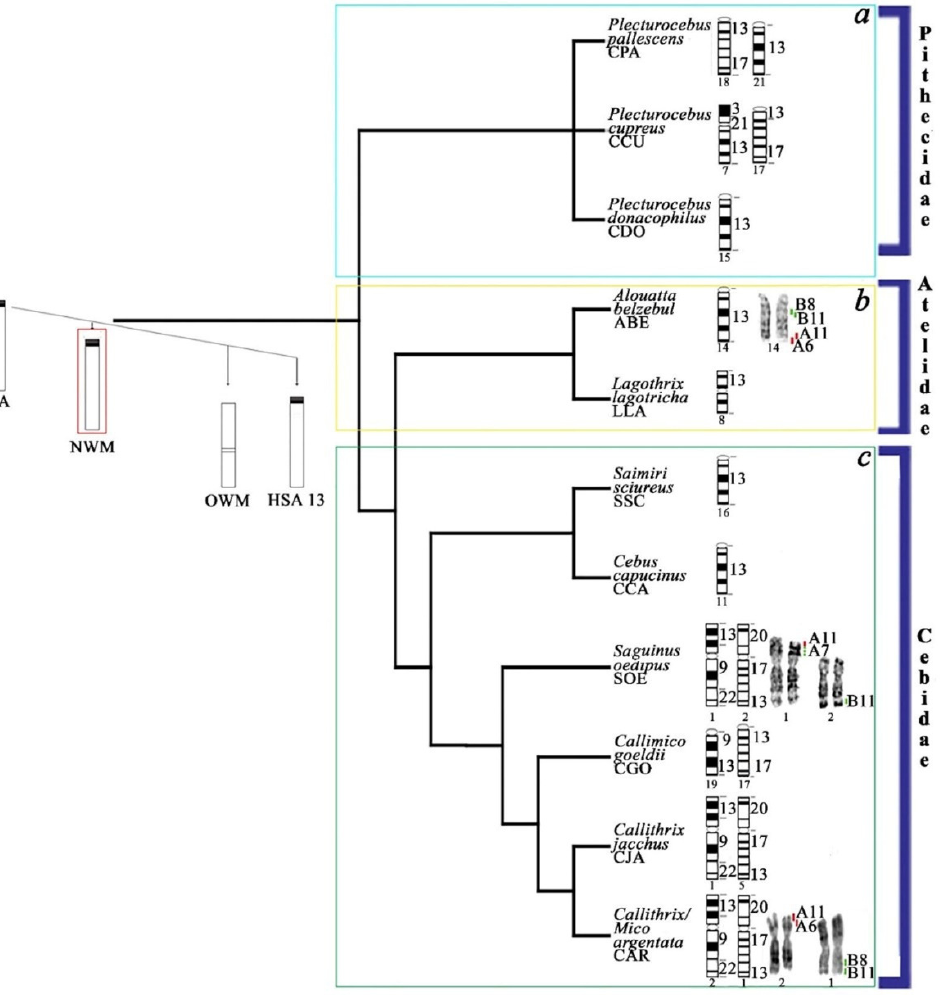
Figure 3. The platyrrhine phylogenetic tree showing the ideograms of the chromosome homologous to HSA13 synteny in representative New World monkeys (NWM). BAC probe mapping (red and green signals) are reported on the right side of banded chromosomes. The species’ chromosome numbers are reported under the ideograms, and HSA synteny associations are on the right. Note that some species previously recognised among the Callicebus genus have now been placed among the new Plecturocebus genus in recent molecular phylogeny [103]. PA—primate ancestor, OWM — Old World monkeys. The tree topology has been here reconstructed and modified according to previous analyses and reconstructions [4,104].